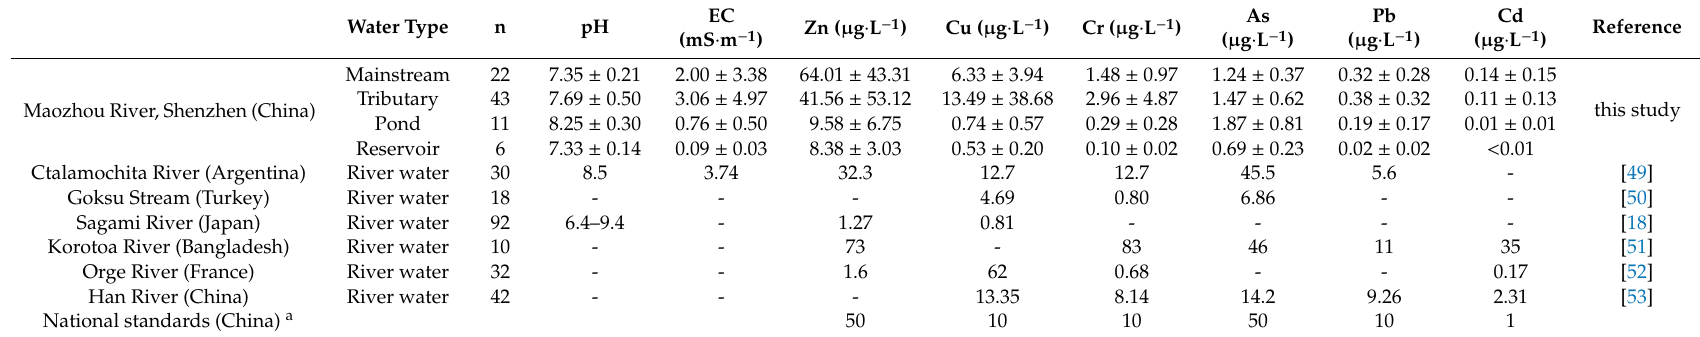
Electrical conductivity (EC); - means not measured. a Class I thresholds of the National Environmental Standard for Surface Water Quality (GB